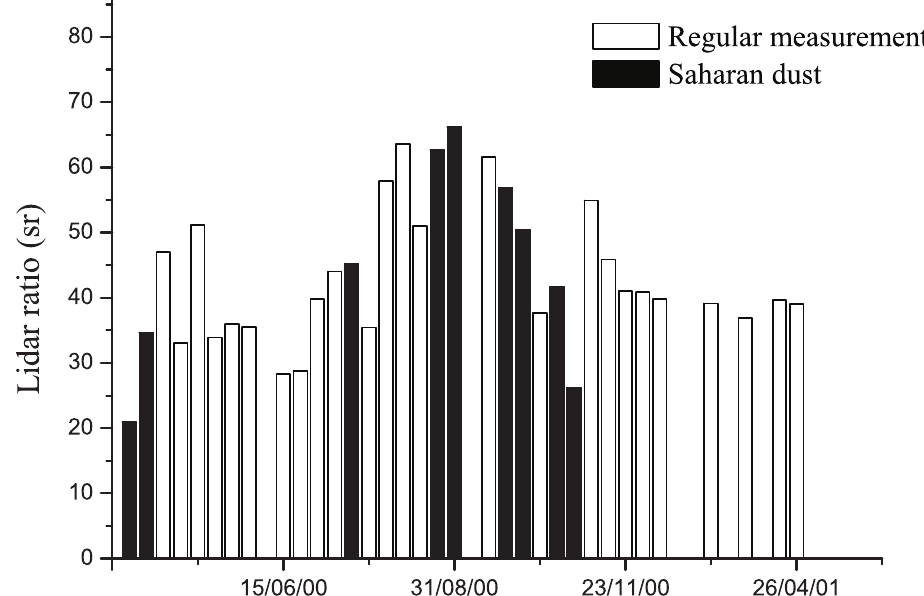
Fig. 9. Mean lidar ratio values at 355 nm for all night time lidar measurements in Tito Scalo in the period May 2000- April 2001. Regular measurements are reported in white, Saharan dust measurements are reported in